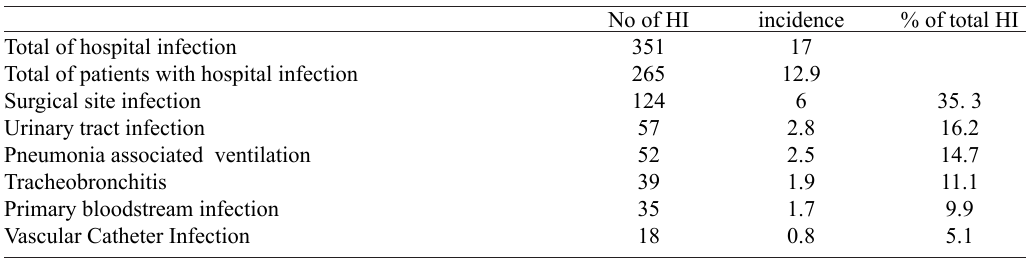
Table 2. Main hospital infections.